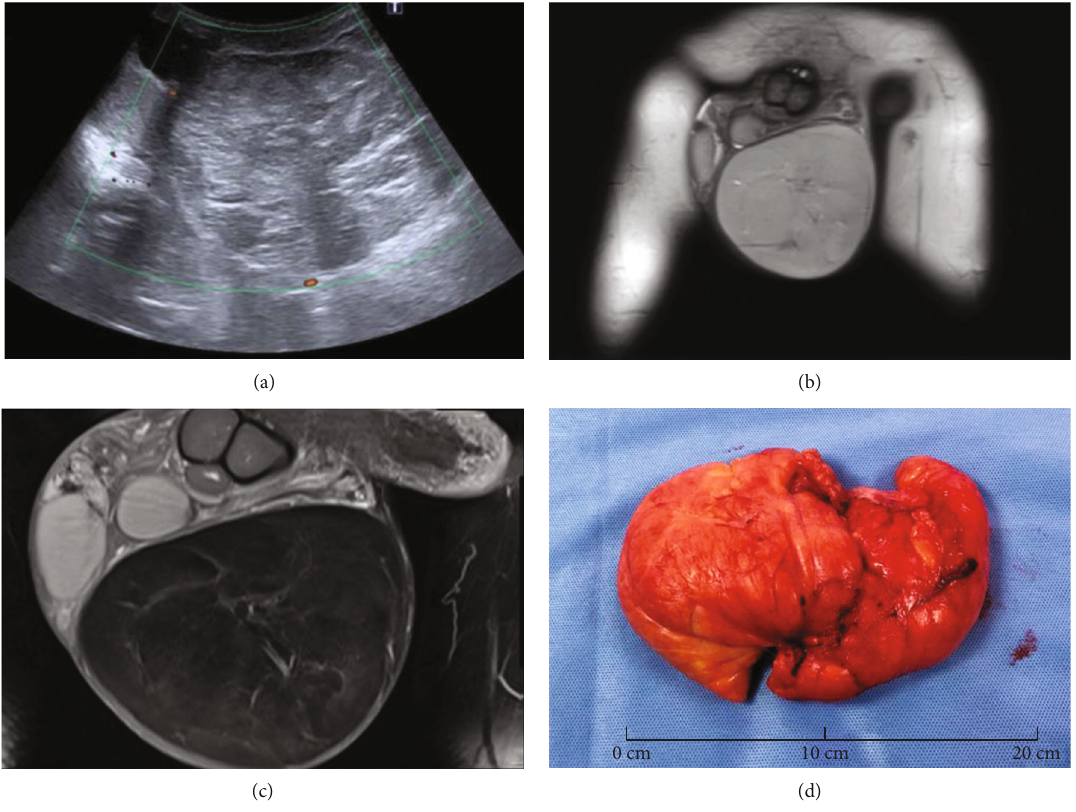
Figure 1: Imaging and gross pathologic features of primary scrotal lipoma. (a) On a color Doppler image, the lesion lacks internal fl ow. (b) Coronal T2-weighted image of the scrotum shows a lesion with homogeneous high signal intensity. (c) Coronal contrast-enhanced T1- weighted MRI shows very low enhancement of the tumor. (d) Gross examination of the surgical